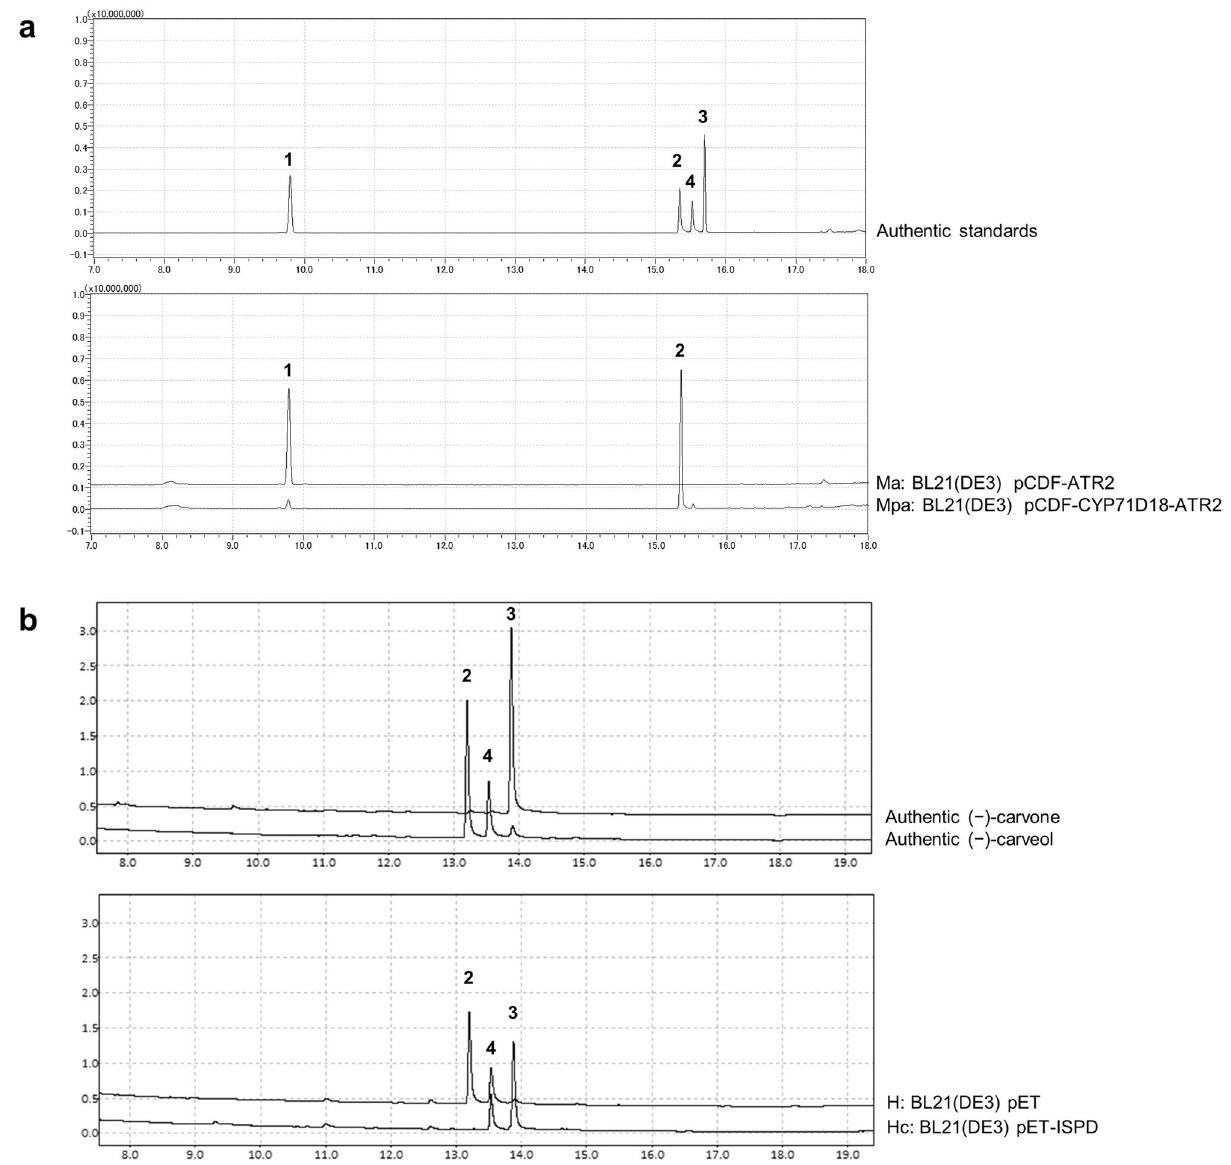
Figure 2. Limonene and carveol conversions for tests of constructed recombinant Escherichia coli strains using a whole-cell biocatalytic system. (a) Reaction with (–)-limonene and cells expressing the cytochrome P450 limonene-6-hydroxylase gene from spearmint ( CYP71D18 ) and/or cytochrome P450 reductase (CPR) gene from Arabidopsis thaliana ( ATR2 ) (Mpa and Ma strains; BL21(DE3) pCDF-CYP71D18-ATR2 and BL21(DE3) pCDF-ATR2) . Mpa strain specifically converted (−)-limonene to (−)- trans -carveol. (b) Reaction with (−)-carveol and cells expressing the carveol dehydrogenase (CDH) gene from peppermint ( ISPD ) (Hc strain; BL21(DE3) pET-ISPD). Hc strain specifically converted (−)- trans -carveol to (−)-carvone. Enzymatic activities were confirmed by gas chromatography (GC) analysis. Upper and lower panels indicate authentic standards and test samples; (−)-limonene ( 1 ), (−)-carveol ( 2 , 4 ), and (−)-carvone ( 3 ). Commercially available (−)-carveol contains (−)- trans -carveol ( 2 ), (−)- cis -carveol ( 4 ), and traces of (−)-carvone ( 3